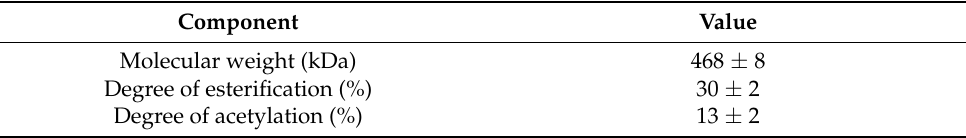
Table 2. Physicochemical characteristics of